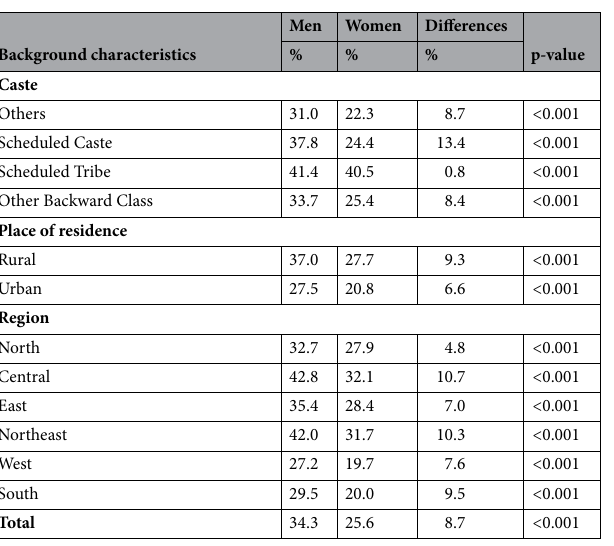
Table 2. Percentage of older adults with successful ageing outcome by obesity-related measures and socioeconomic and demographic characteristics in India, 2017–2018. MPCE: monthly per capita consumption